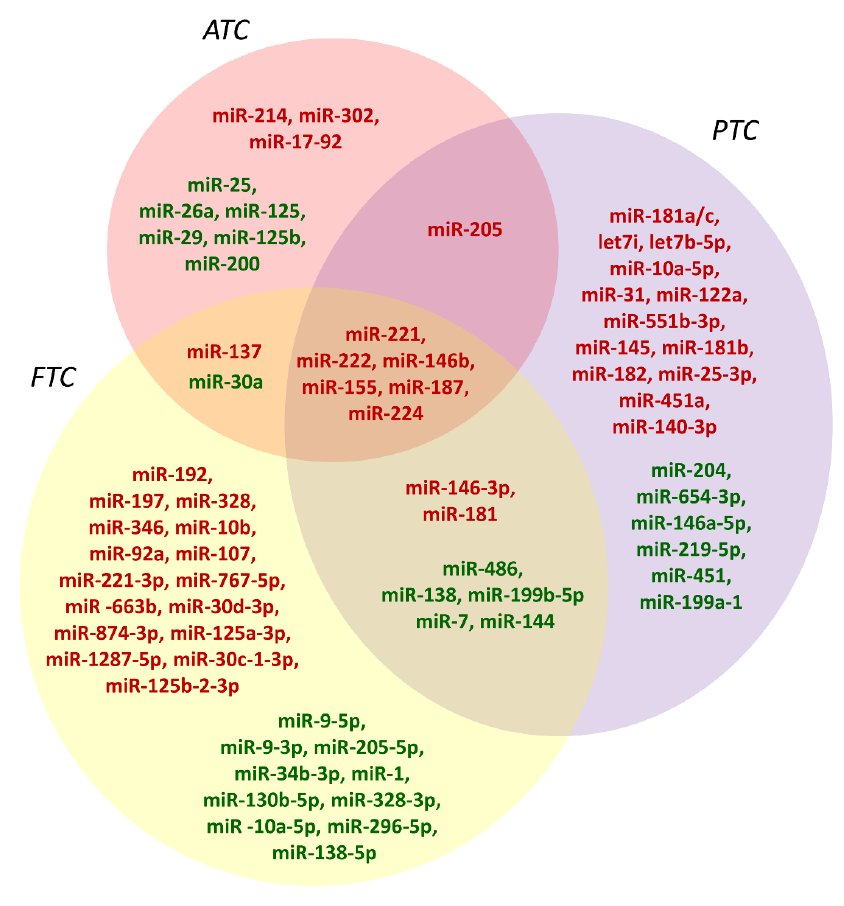
Figure 2. The landscape of miRNAs differentially expressed in the diverse histotypes of thyroid-follicular-cell-derived carcinomas. Upregulated miRNAs are indicated in red, while downregulated ones are indicated in green. FTC, follicular thyroid carcinoma; PTC, papillary thyroid carcinoma; ATC, anaplastic thyroid carcinoma.